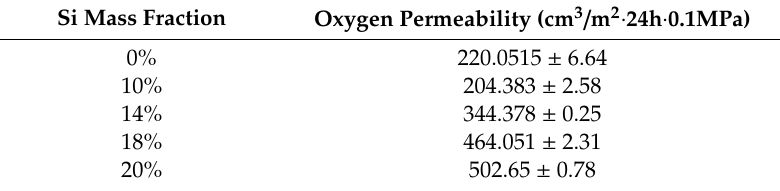
Table 2. Oxygen transmission rate of the Si / PC copolymer with di ff erent Si mass